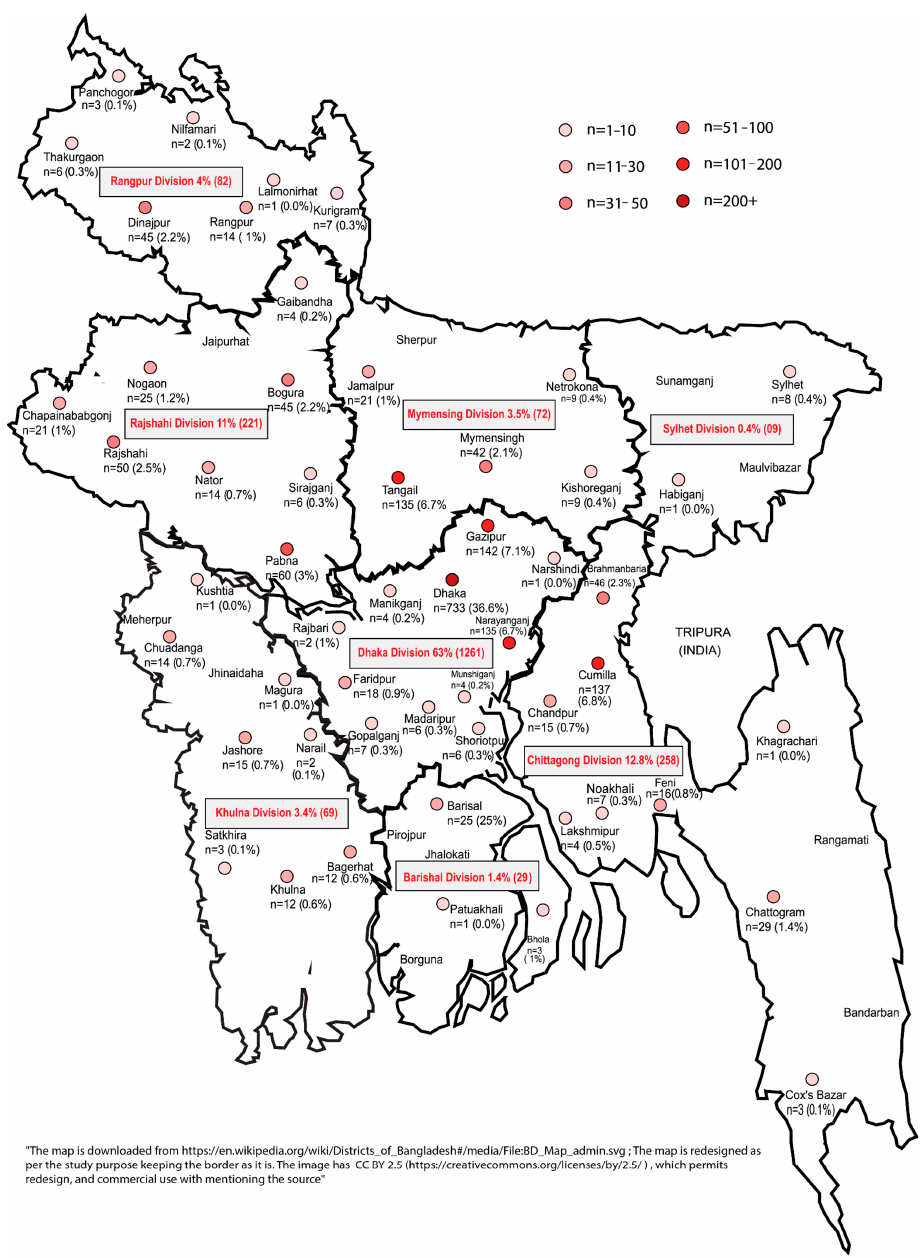
Figure 2. The population distribution of the respondents. Downloaded from https://en.wikipe- dia.org/wiki/Districts_of_Bangladesh#/media/File:BD_Map_admin.svg (accessed on 1 January 2020.) and redesigned as per the study purpose keeping the border as it is. The image has CC BY 2.5 (https://creativecommons.org/licenses/by/2.5/ (accessed on 1 January 2023)), which permits rede- sign and commercial use with mentioning the https://en.wikipedia.org/wiki/Districts_of_Bangla- desh#/media/File:BD_Map_admin (accessed on 1 January 2023)